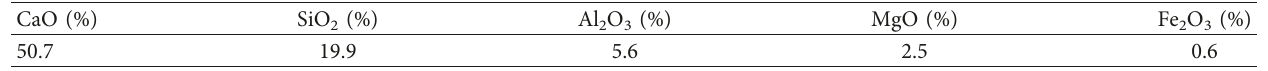
Table 2: Main composition of stone